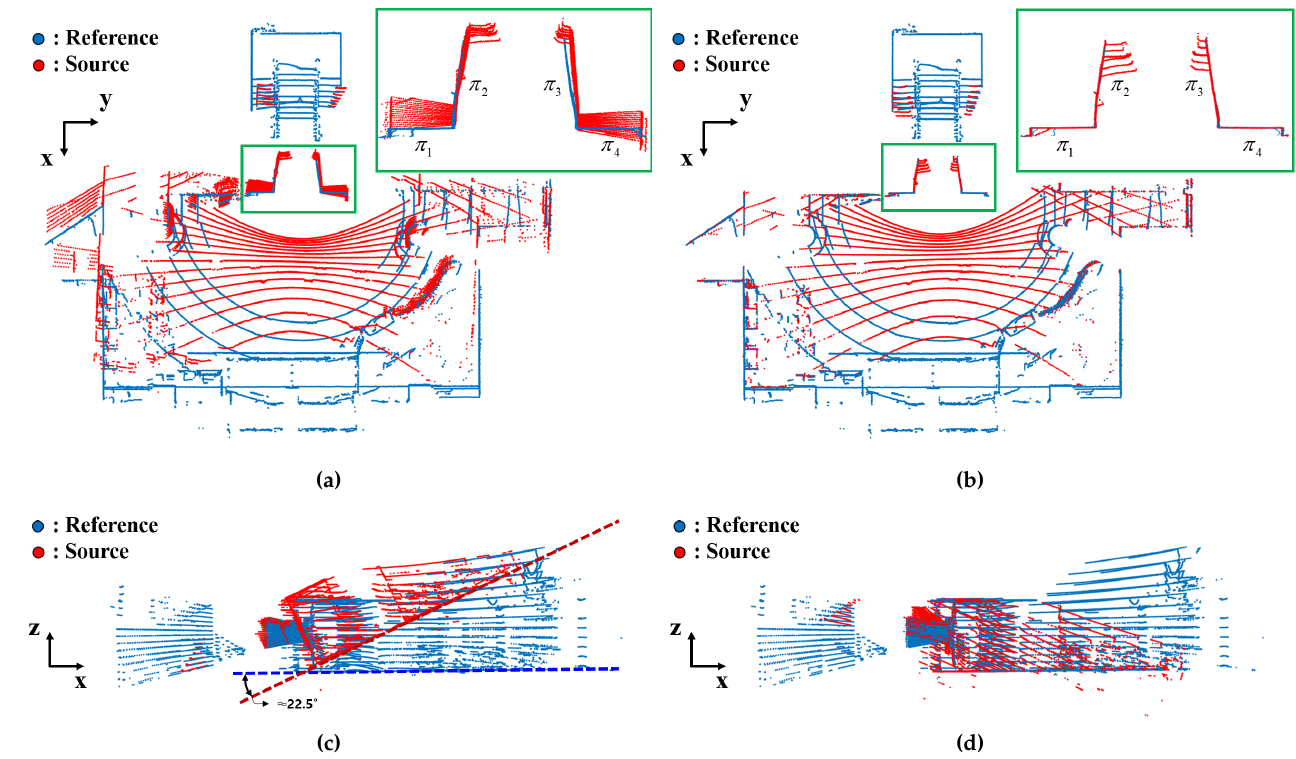
Figure 7. Point clouds from the reference (blue dots) and source (red dots) LiDAR sensors of the robotic system. Top view of the point cloud ( a ) before and ( b ) after calibration. The magnified area of the top views represent the environment shown in Figure 4a. Side view of the point cloud ( c ) before and ( d ) after calibration. The dashed lines in the side views correspond to the ground